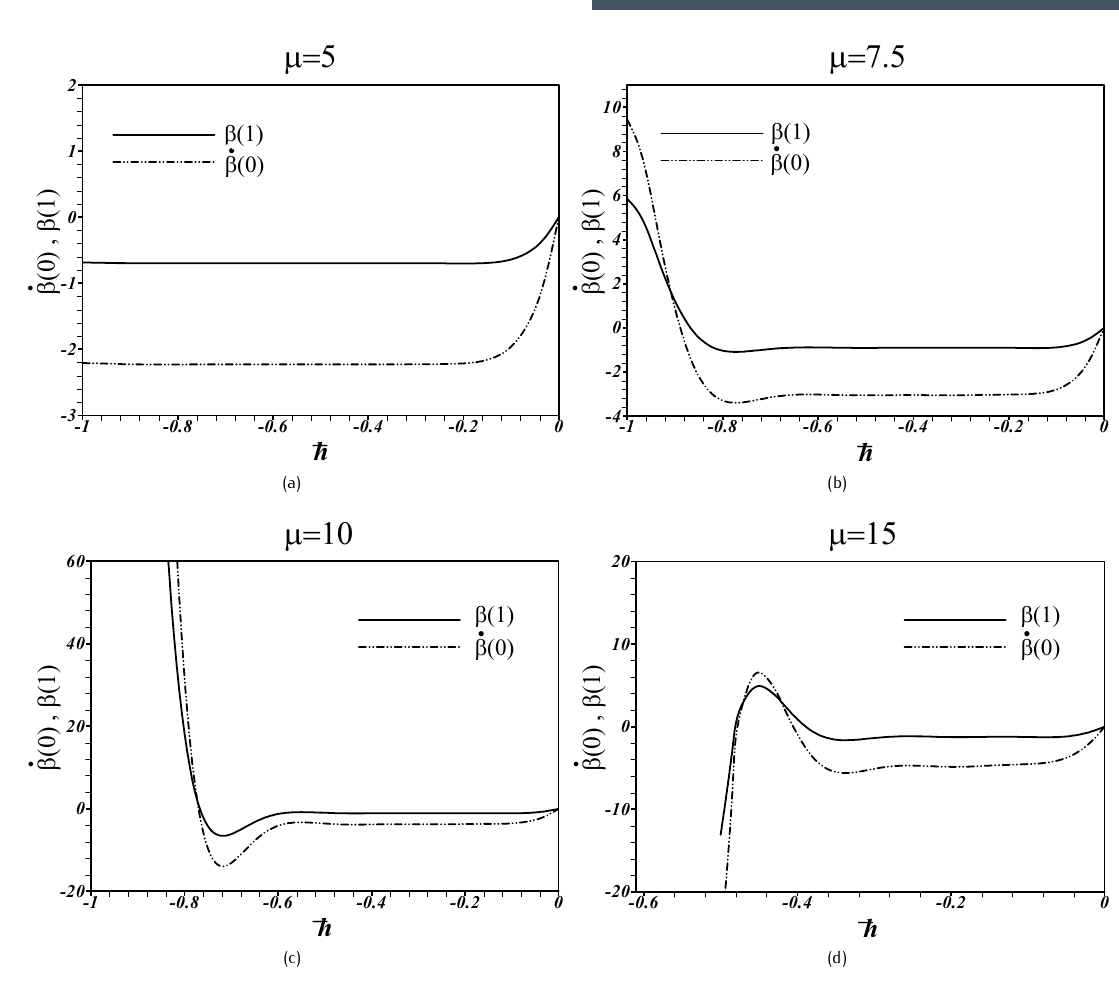
Figure 3. The (cid:126) curve, (a) µ = 5 , (b) µ = 7 . 5 , (c) µ = 10 and (d) µ = 15 . 20 th -order approximation. beamshell for different load cases are presented in Fig. 4 and Fig. 5 respectively, and the influence of dimensionless weight parameter is shown.